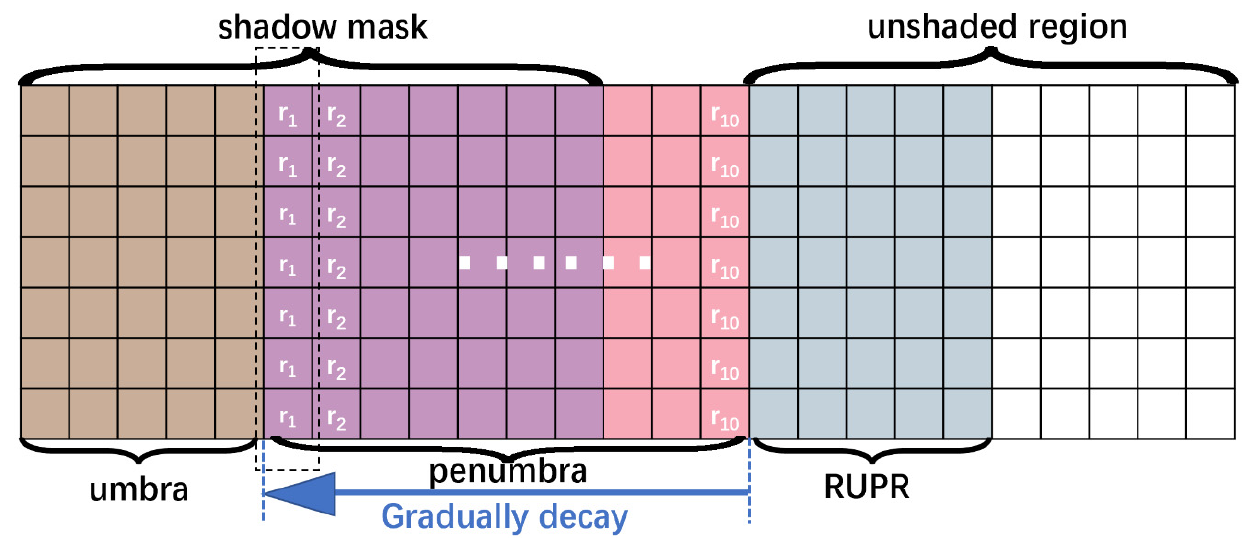
Figure 6. Penumbra removal: ( a ) original image; and ( b ) the result of shadow compensation; ( c ) the region sampled for penumbra removal; ( d ) shadow sketch map: white for umbra, gray for penumbra and black for unshaded region; and ( e ) shadow mask obtained in shadow detection.